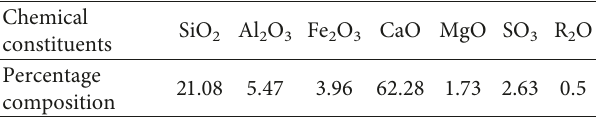
Table 1: The chemical constituents and percentage composition of